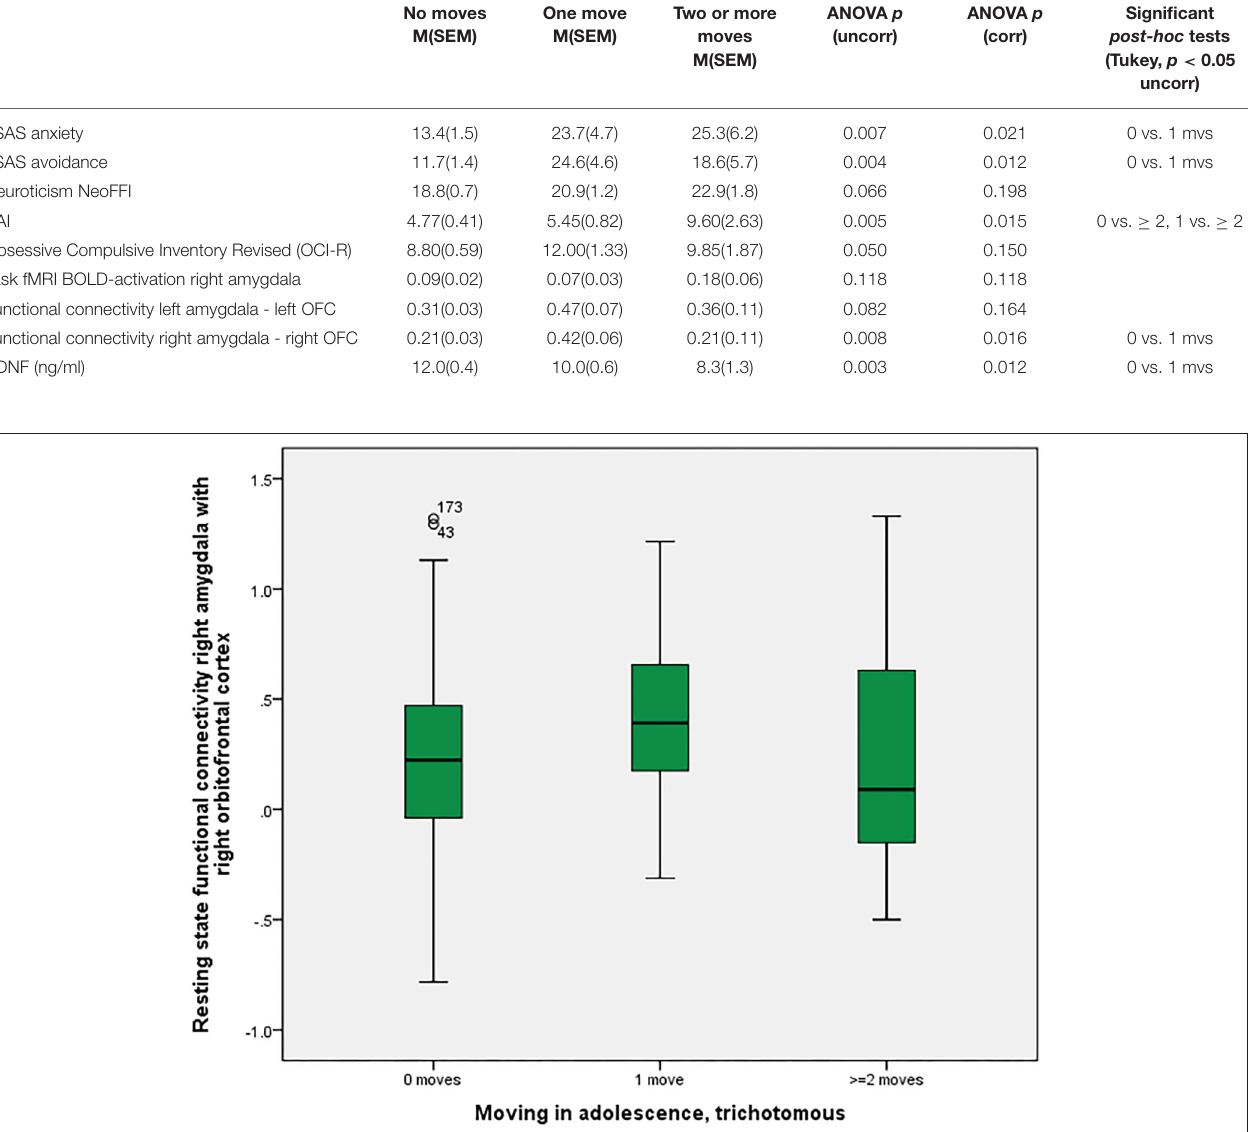
FIGURE 2 | Residential mobility in adolescence and functional connectivity right amygdala—right orbitofrontal cortex. Boxplot for the group comparison in functional connectivity between right amygdala and right orbitofrontal cortex (qualitatively similar for other amygdala-orbitofrontal connectivities, e.g., left amygdala-left orbitofrontal cortex; beta-values corrected for scan-to-scan motion and activations in the white matter/CSF segments) between subjects who did not move during adolescence (M = 0.21, SEM = 0.03, n = 161) with subjects who moved one time (M = 0.42, SEM = 0.06, n = 41) and twice or more than twice (M = 0.21, SEM = 0.11, n = 20). The ANOVA for simultaneous 3-group comparison is significant ( p uncorrected = 0.008, with Bonferroni-Holm correction p = 0.016). Uncorrected post-hoc Tukey tests showed a significant result for zero moves vs. one move ( p = 0.006), but not for the other comparisons (zero with two or more: p = 0.999; one with two or more: p =